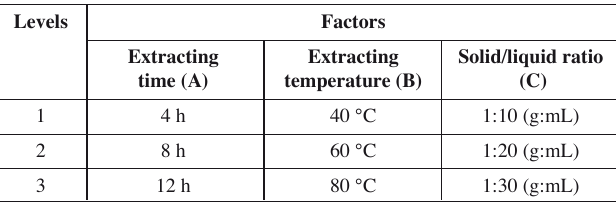
Tab. 1: Extracting parameters and levels for orthogonal array